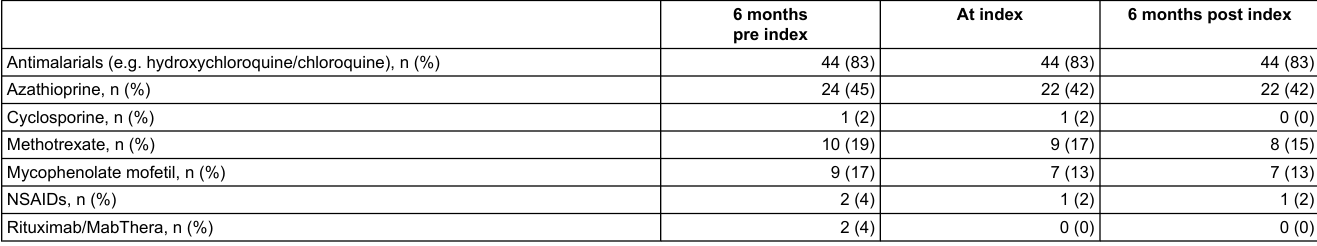
Table S1: Number of patients receiving concomitant SLE medications other than corticosteroids (n = 53).